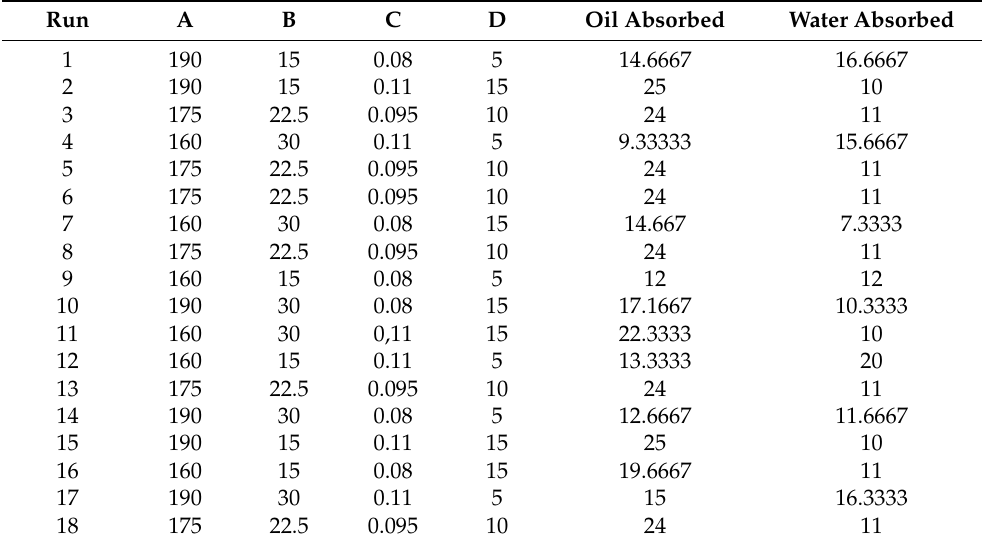
Table 3. Screening of significant parameters affecting oil and water effluent using Plackett– Burman. Run